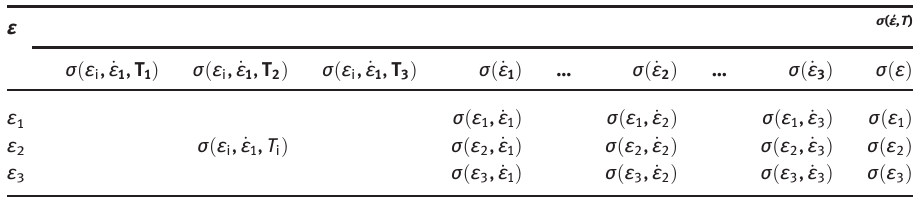
Table 2: The table ε − σ ð _ ε i , T i Þ of three test factors with three